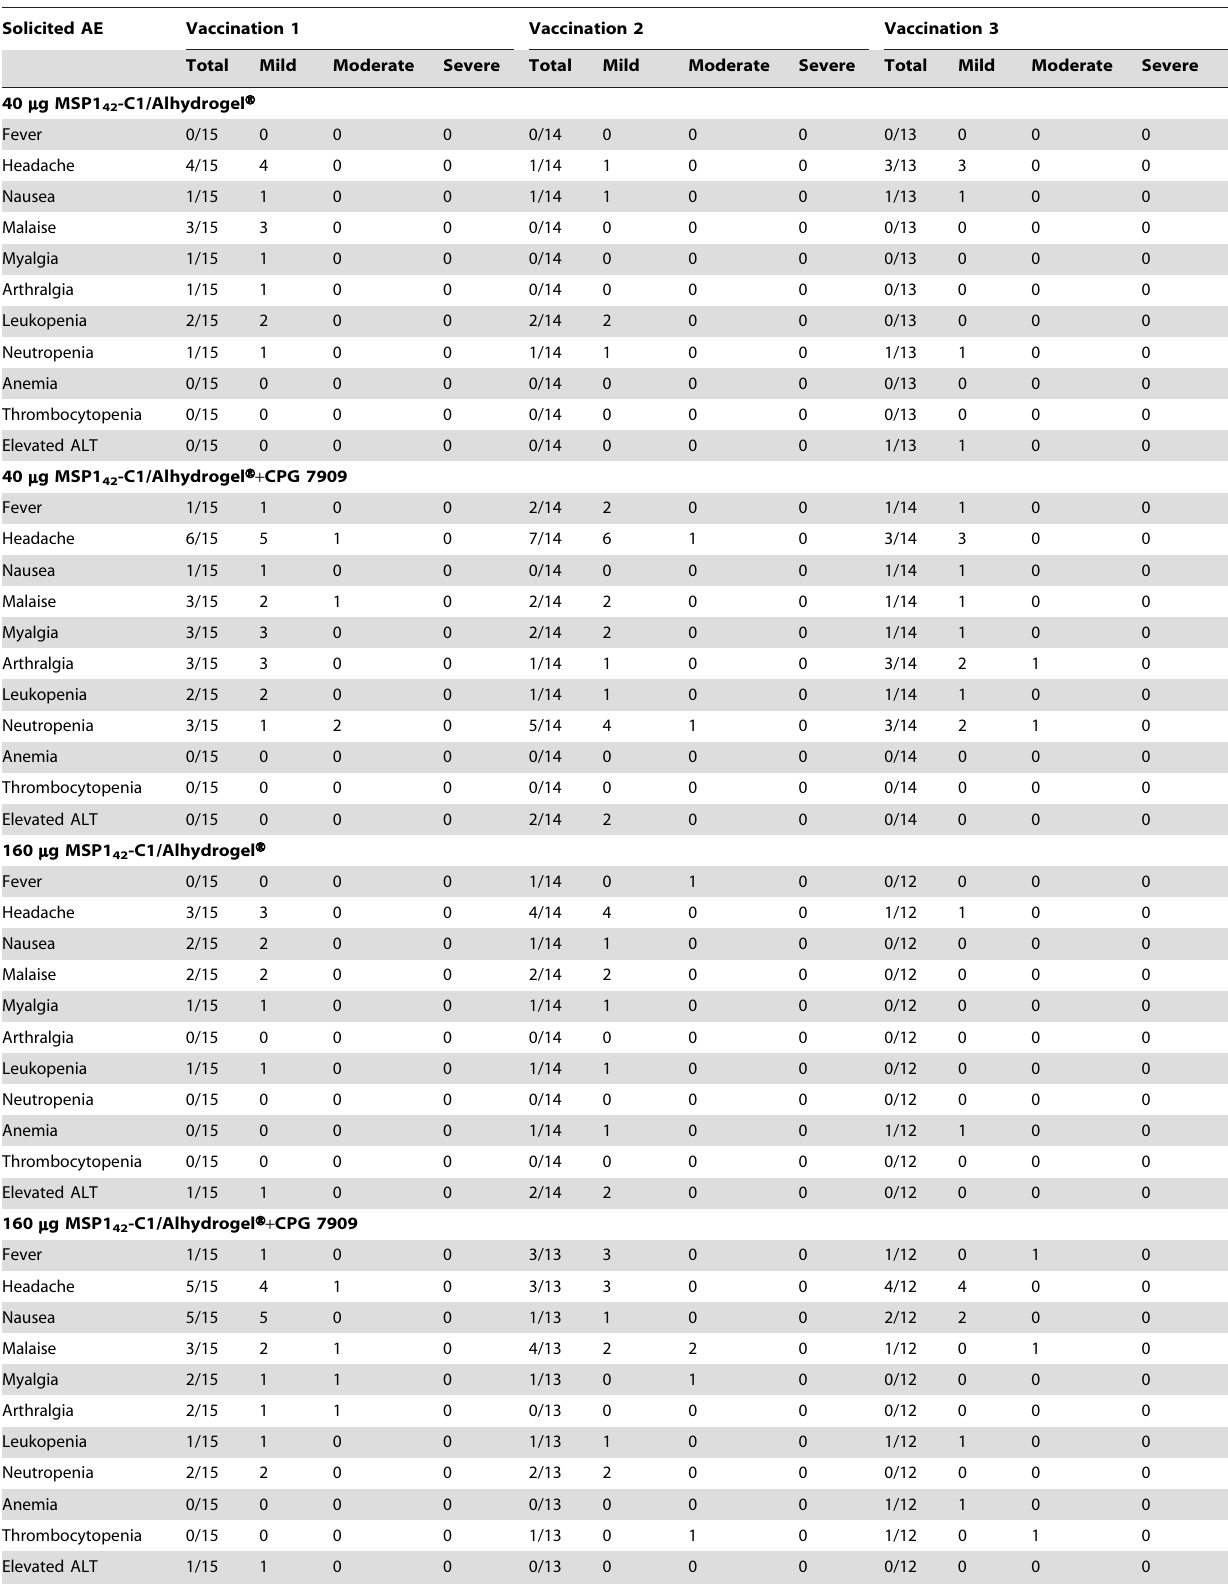
Table 2. Solicited systemic and selected laboratory adverse